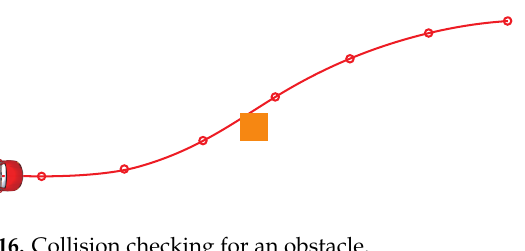
Figure 16. Collision checking for an